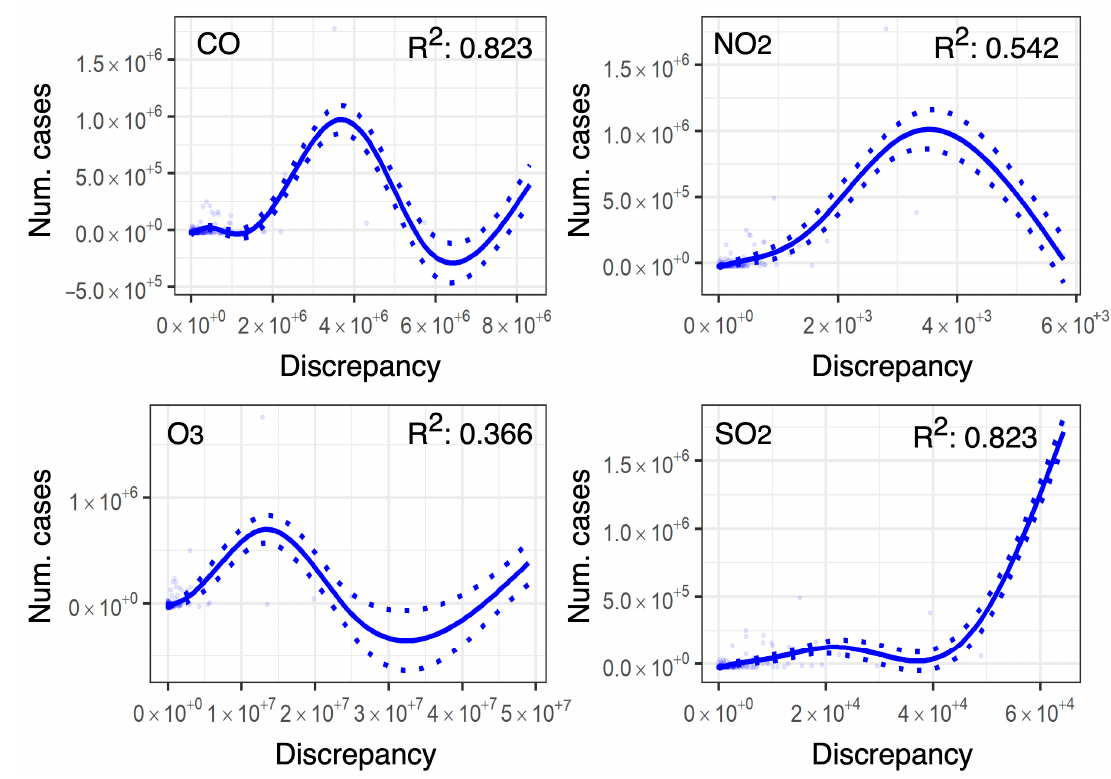
Figure 2. Non-linear relationship between air pollution discrepancies and confirmed cases of COVID-19. ( a ) CO discrepancy and confirmed cases. ( b ) NO 2 discrepancy and confirmed cases. ( c ) O 3 discrepancy and confirmed cases. ( d ) SO 2 discrepancy and confirmed